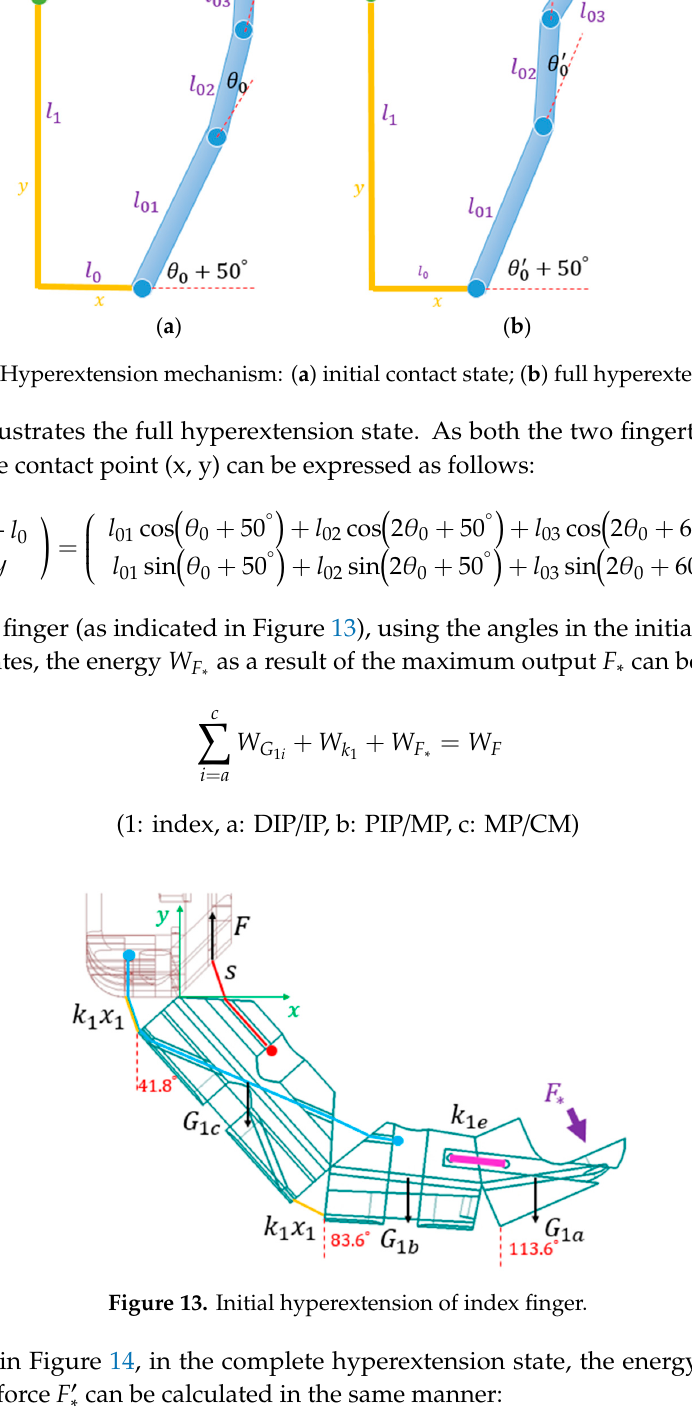
Figure 14. Complete hyperextension of index finger.